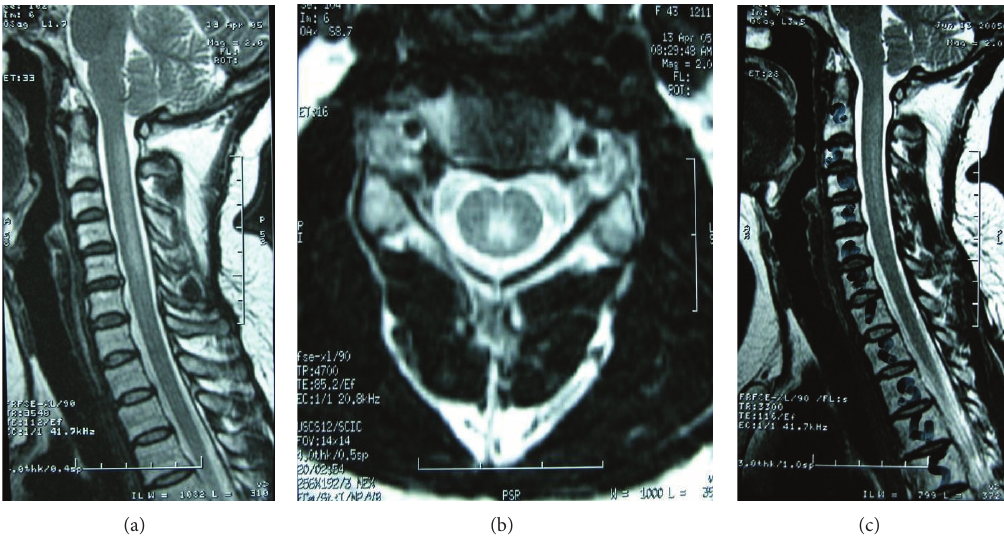
Figure 3: ((a), (b)) Sagittal and axial T2 weighted images of the cervical cord before treatment demonstrate high signal bilaterally in the posterior columns of the cord. (c) The posttreatment images 2 months later show a striking reduction of the MRI